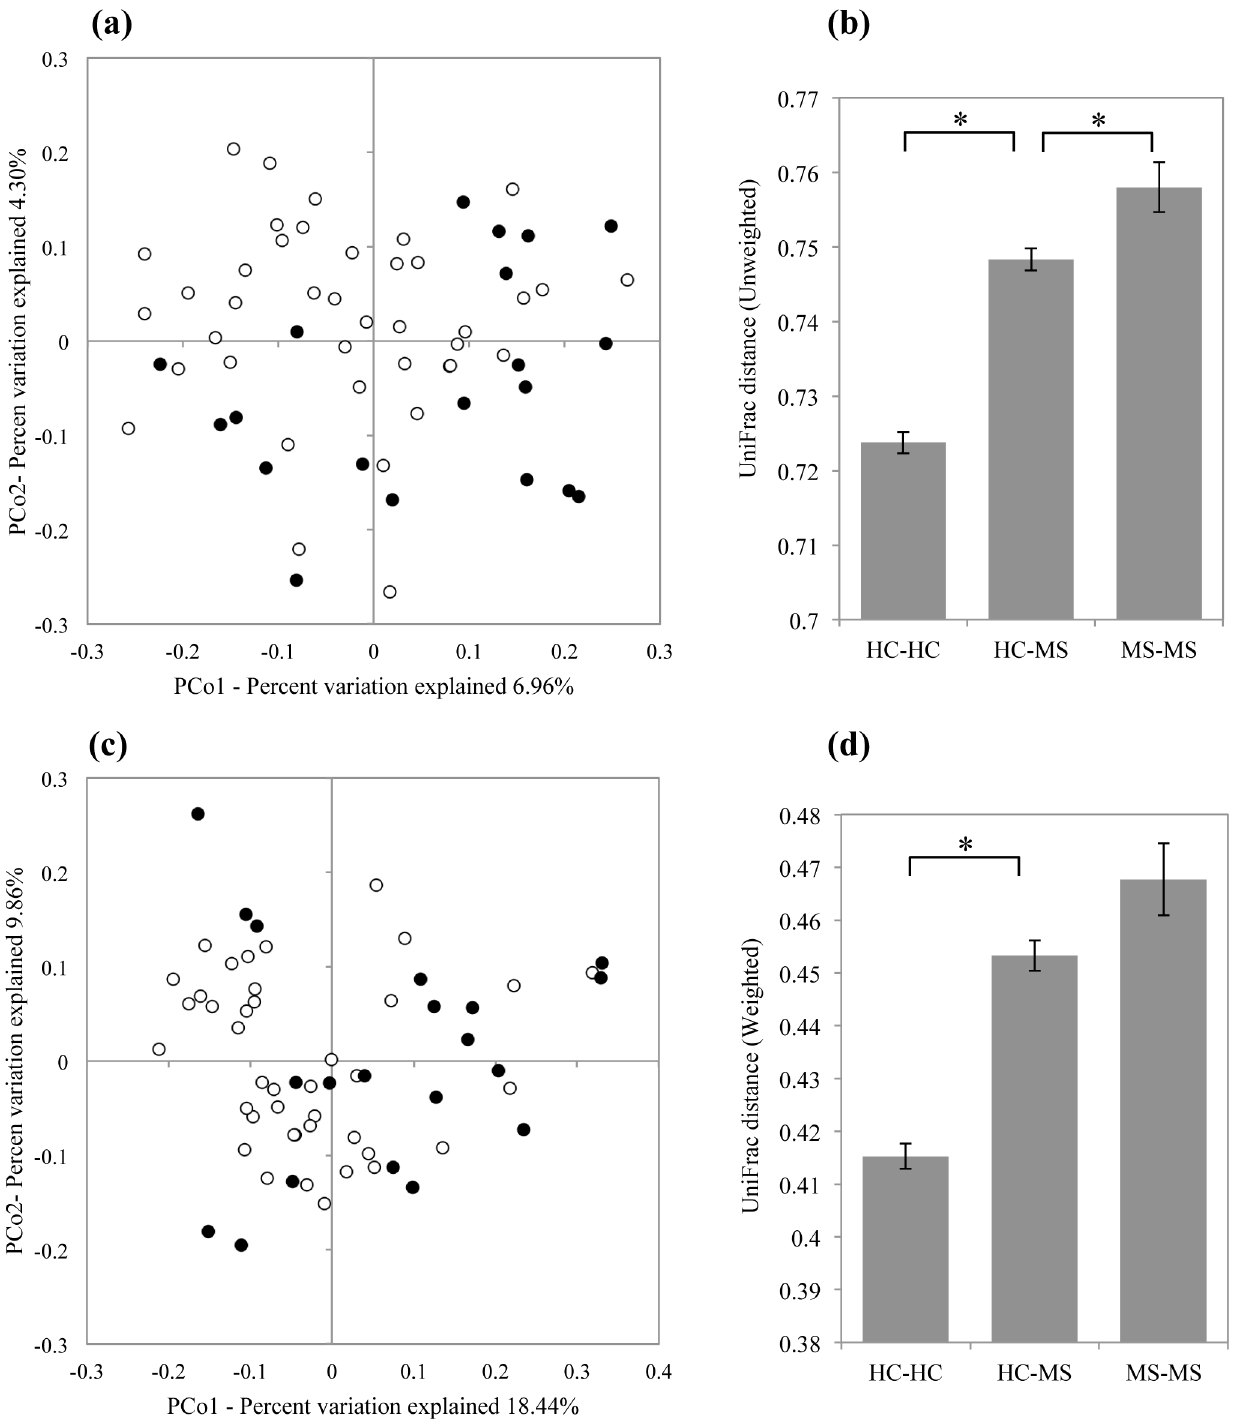
Fig 2. UniFrac Principal Coordinate (PCoA) and UniFrac distance analyses for HC40 and MS20 subjects. (a, c) Open and closed circles indicate individual subjects from HC40 and MS20, respectively. (a) The two components of the unweighted PCoA plot explained 6.96% and 4.30% of the variance. ANOSIM statistic, R = 0.239, P (cid:3) 0.0009. (b) Mean unweighted UniFrac distances for HC-HC, HC-MS, and MS-MS subjects. (c) The two components of the weighted PCoA plot explained 18.44% and 9.86% of the variance. ANOSIM statistic, R = 0.208, P (cid:3) 0.002. (d) Mean weighted UniFrac distances for HC-HC, HC-MS, and MS-MS subjects. (b, d) Error bars represent standard deviations of the UniFrac distances between samples. * P (cid:3) 0.05.